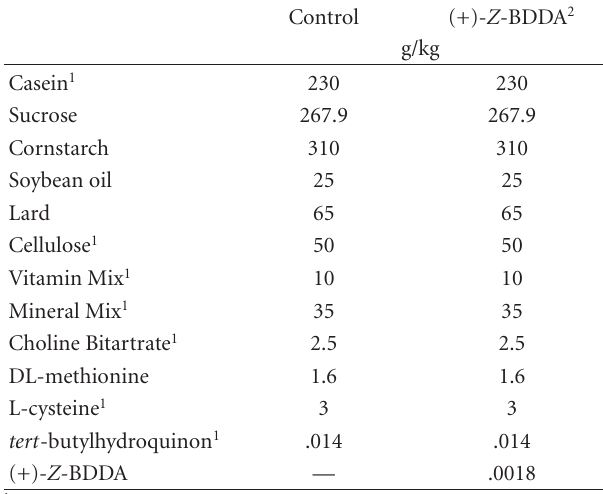
Table 1: Composition of experimental diets.